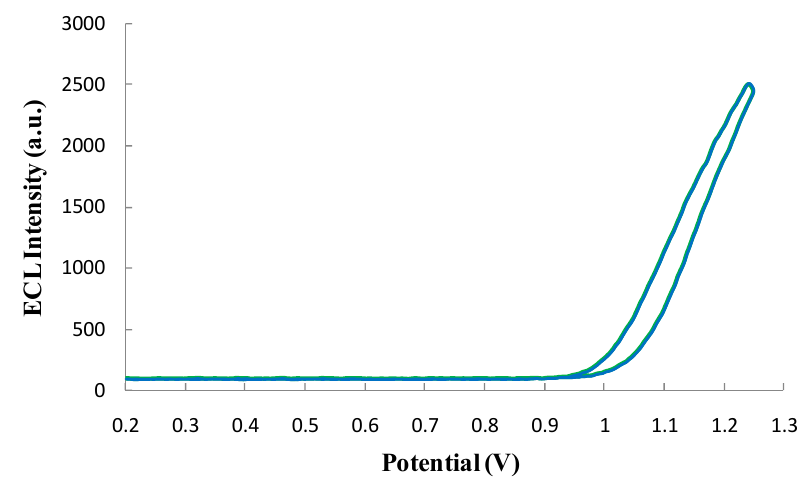
Figure 11. ECL profile of luminescence probe.